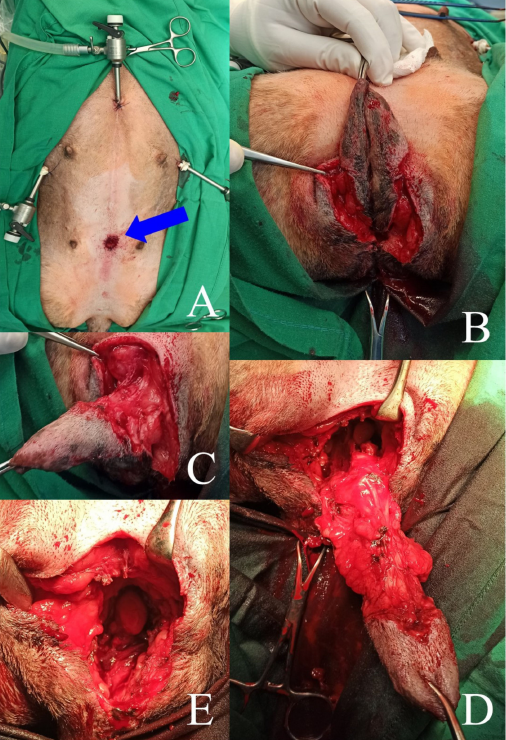
Figure 2. ( A ) Intraoperative image of medial prepubic urethrostomy—blue arrow. ( B ) Cutaneous incision line in vulvovaginectomy. ( C , D ) Preparation of the vulva and vaginal vestibule during hybrid surgery. ( E ) Intraoperative external image of the wound after vulva removal.